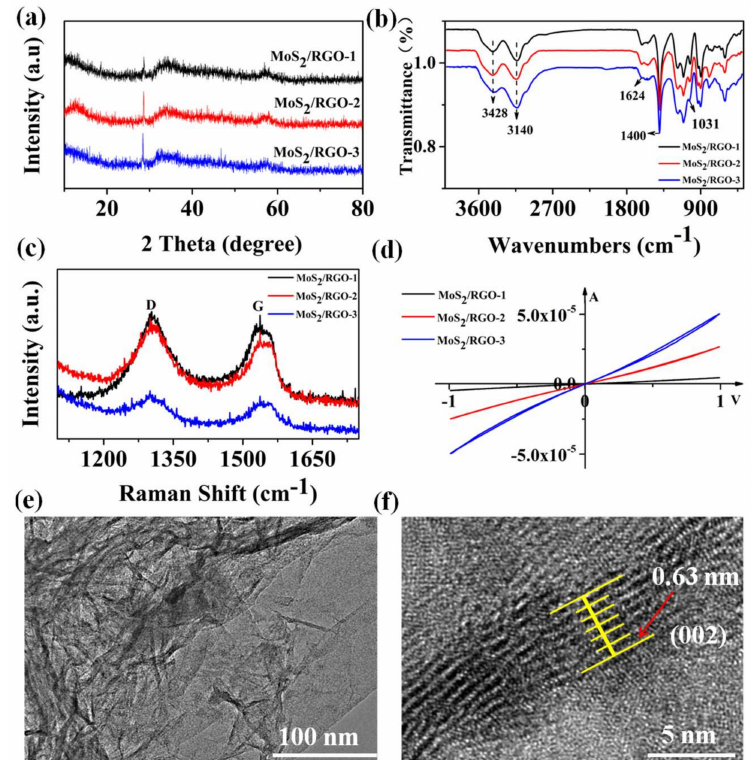
Figure 3. ( a ) XRD patterns, ( b ) FT-IR spectrum, ( c ) Raman spectrum of MoS 2 /RGO-1, MoS 2 /RGO-2, and MoS 2 /RGO-3 composites; ( d ) I–V curves of sensors 1, 2, 3 and ( e , f ) TEM images of MoS 2 /RGO-3